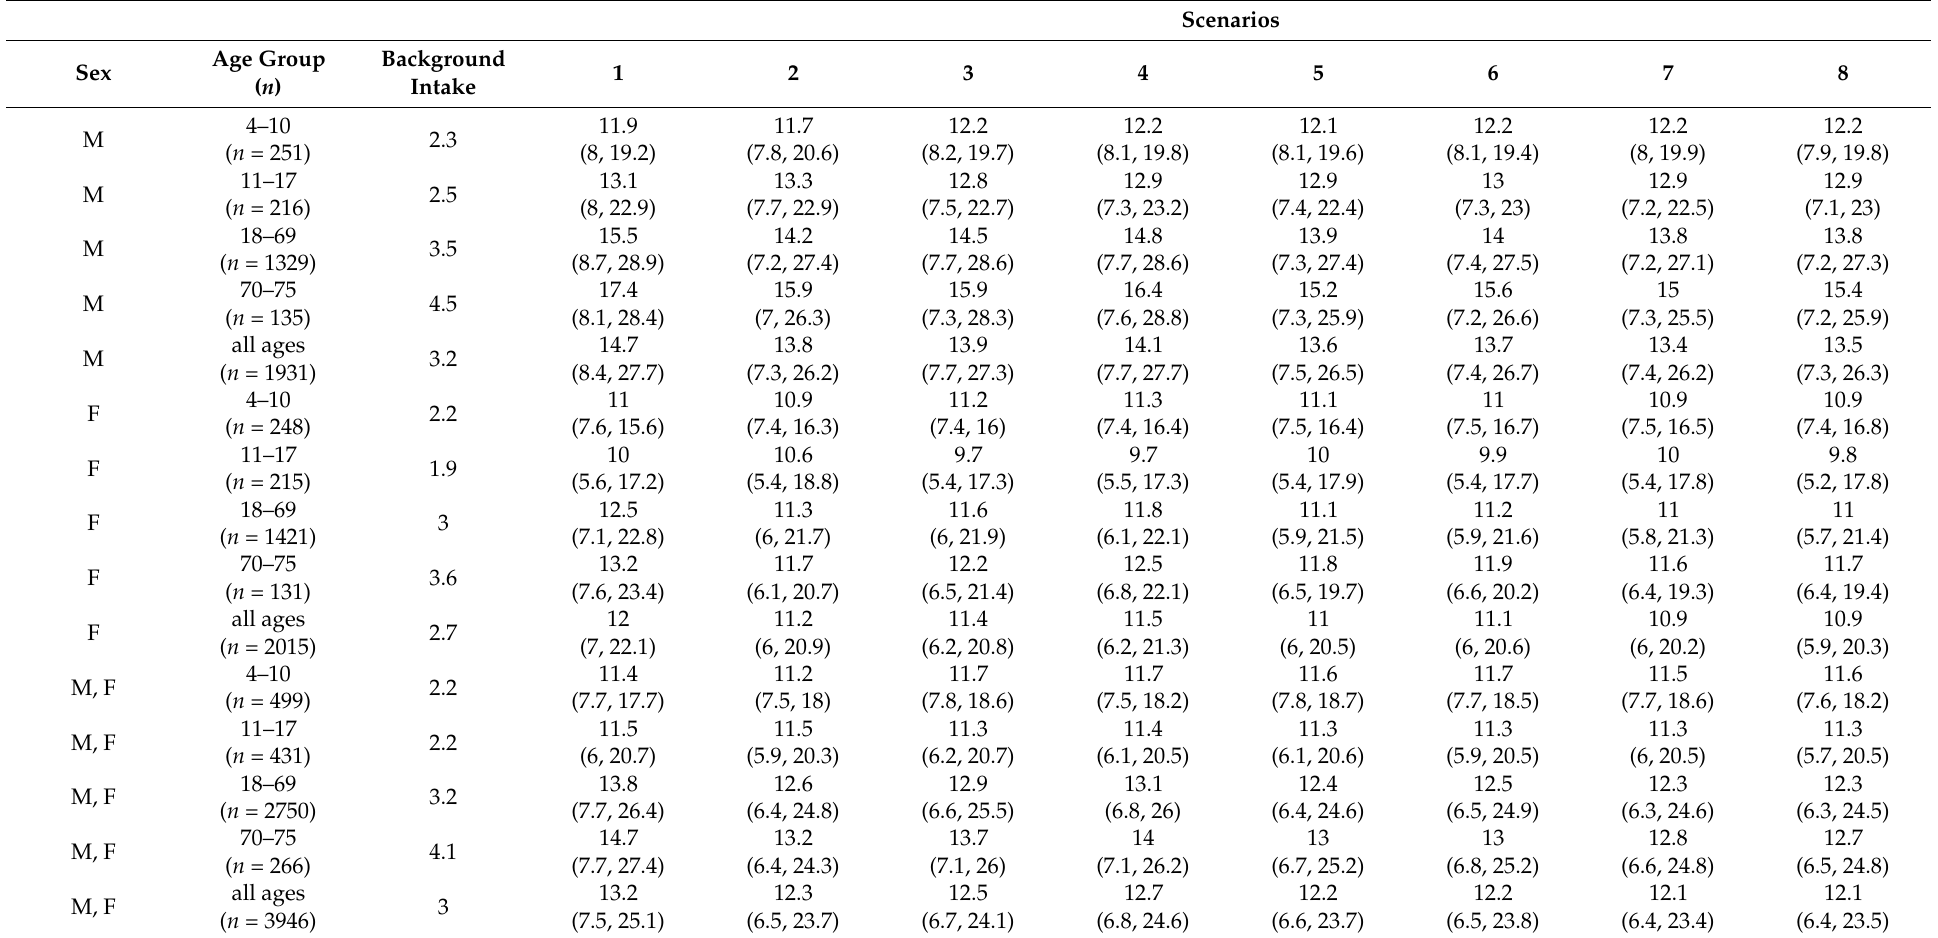
Table 3. Median (P5, P95) vitamin D intake ( µ g/day) for different age (years) and sex (M = male, F = female) groups of the population at background intake and optimized